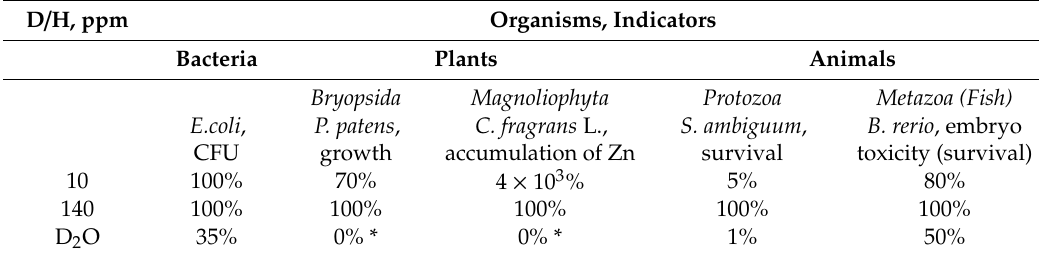
Table 2. The influence of the changed D / H isotopic composition in water on the values of vital indicators of di ff erent taxonomic groups of organisms. (Control—indicators in water with the natural ratio of deuterium / protium (140 ppm);